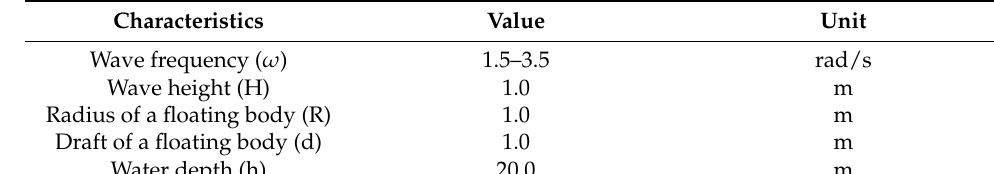
Figure 2. Mesh system of 3F-FR-NWT: ( a ) full domain; ( b ) body mesh.